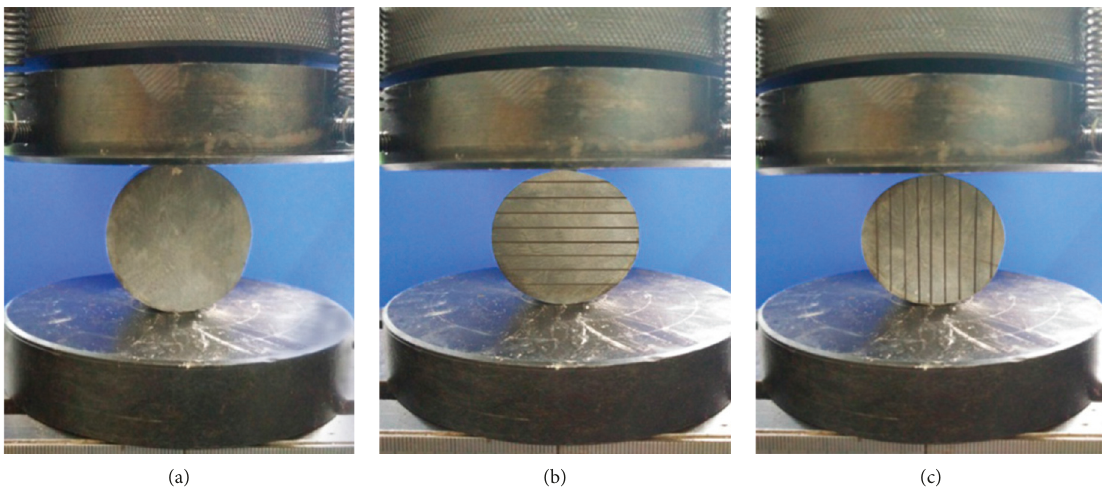
Figure 6: The tensile strength of (a) Type A, (b) Type B, and (c) Type C specimens measured by Brazilian disc